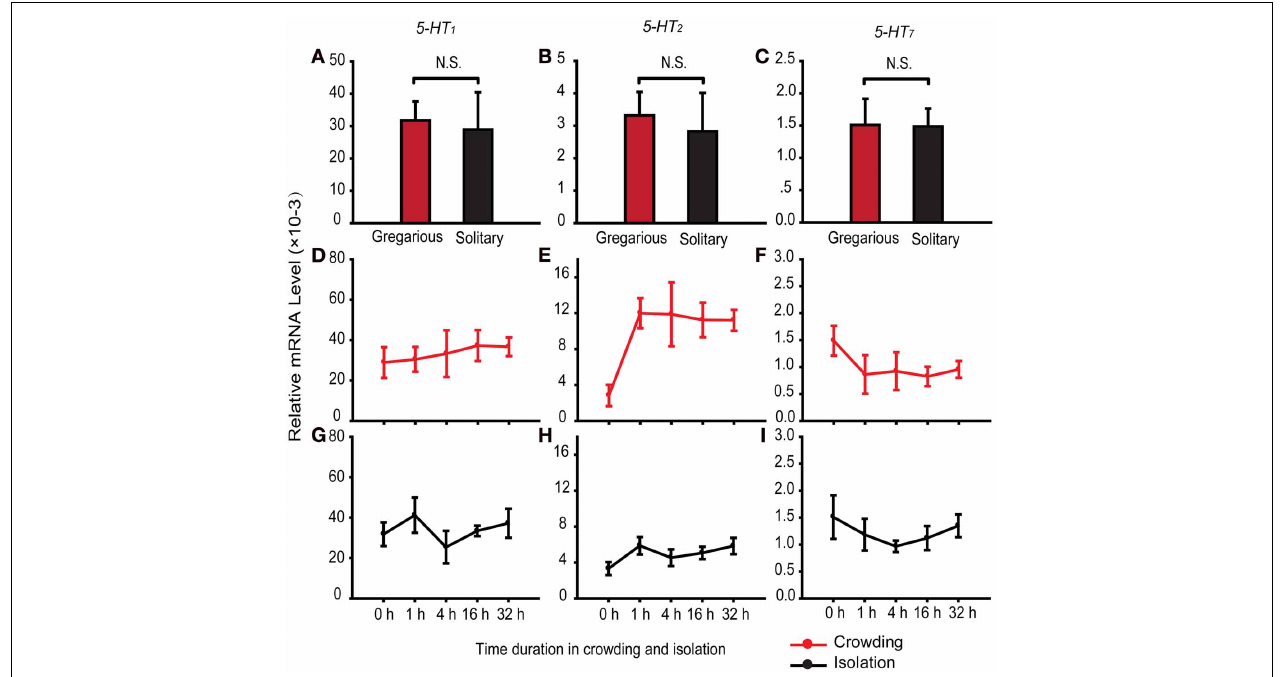
P = 0 . 937 for 5-HT 1 ; F ( 4 , 35 ) = 4 . 574, P = 0 . 003 for 5-HT 2 ; F ( 4 , 35 ) = 1 . 756, P = 0 . 173 for 5-HT 7 ]. (G–I) Expression patterns of 5-HT 1 (G) , 5-HT 2 (H) , and 5-HT 7 (I) in the brains of fourth-stadium gregarious nymphs during isolation [One-Way ANOVA, F ( 4 , 15 ) = 1 . 240, P = 0 . 332 for 5-HT 1 ; F ( 4 , 15 ) = 1 . 163, P = 0 . 207 for 5-HT 2 ; F ( 4 , 15 ) = 1 . 824, P = 0 . 159 for 5-HT 7 ]. The data represent mean values and error bars represent SEM. Abbreviations: G, gregarious; S, solitary. N.S., not significant.